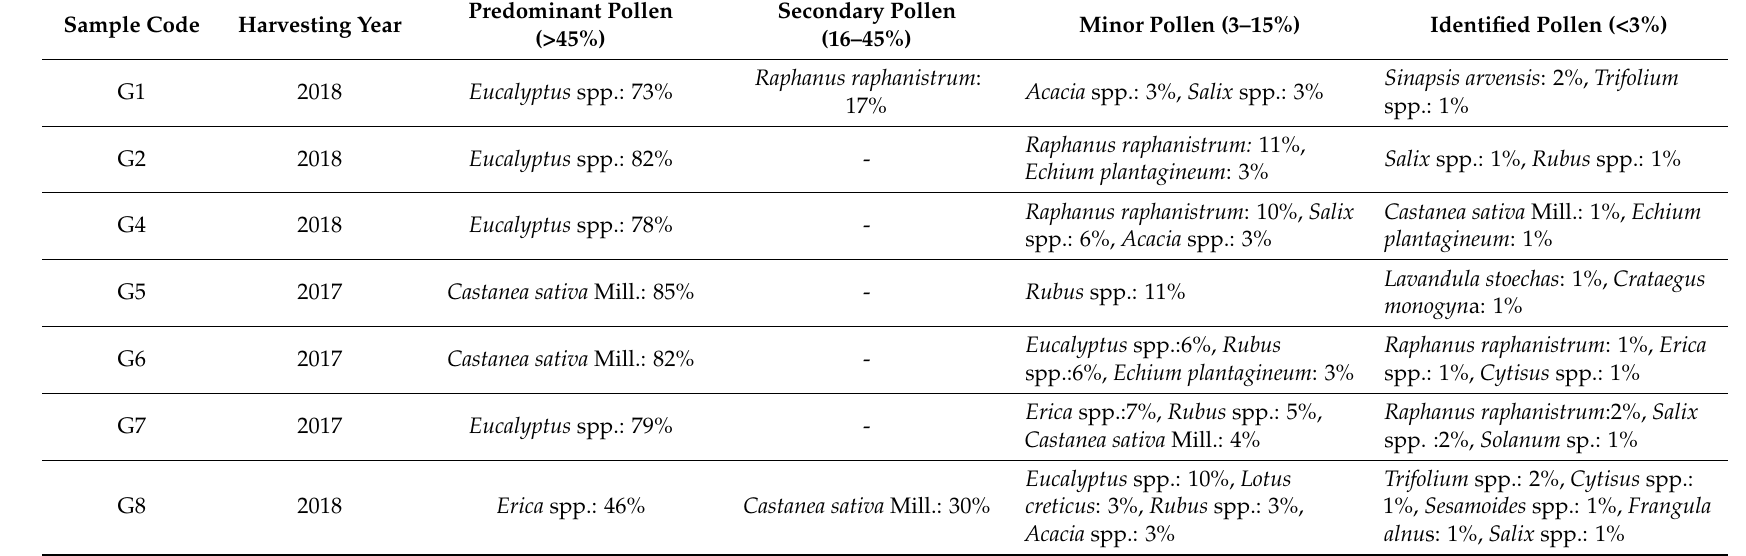
Table 1. Sample coding, harvesting year and melissopalynological data of Portuguese honey samples analysed in the present